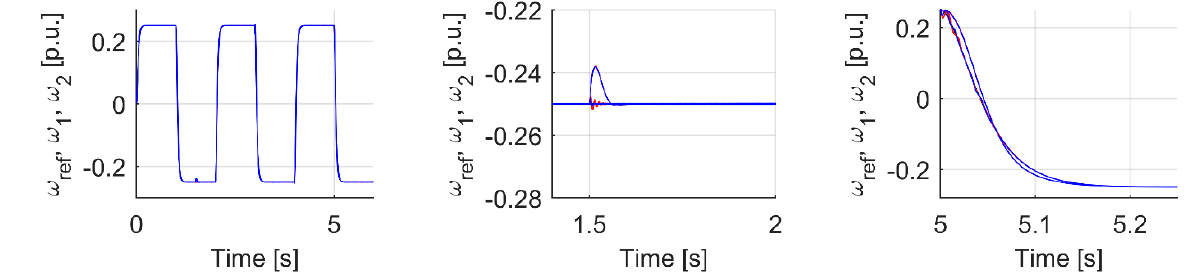
Figure 26. Transients of motor, load and reference speed for analyzed controller cases.